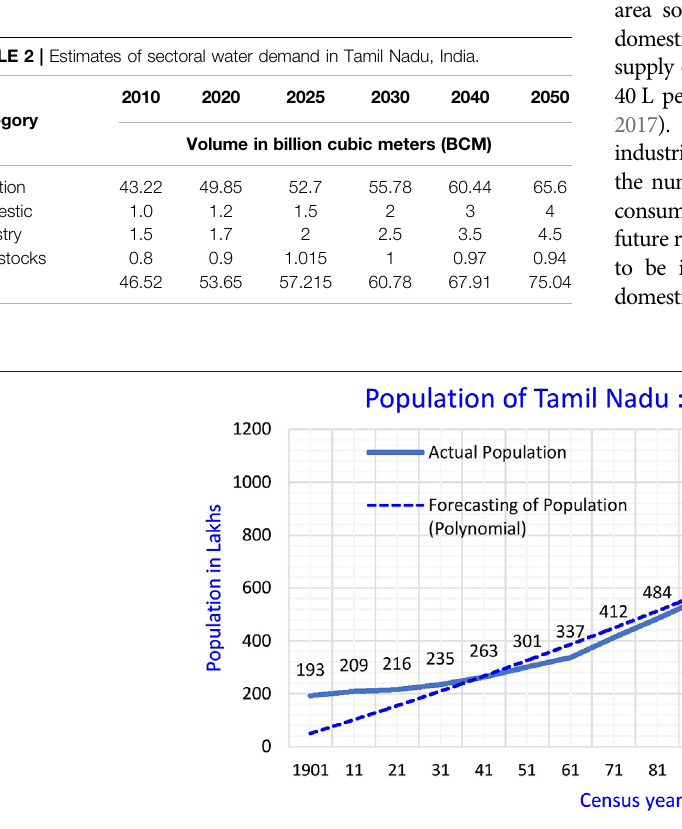
FIGURE 5 | Population of Tamil Nadu: 1901 – 2021, source: Census of India.